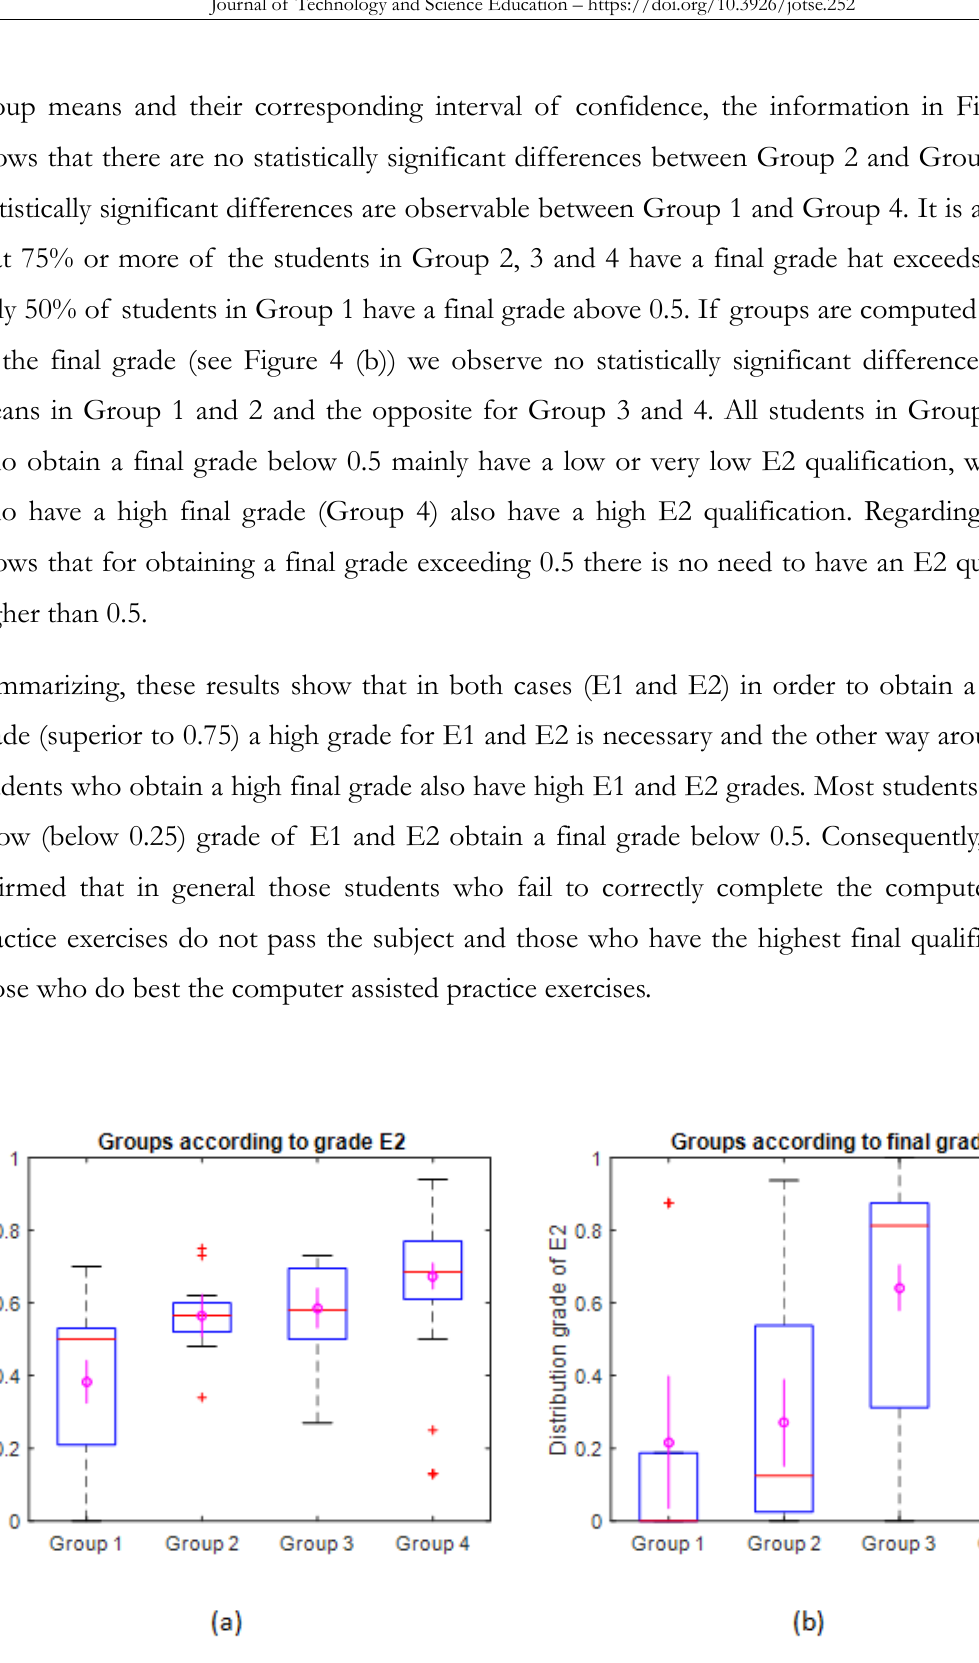
Figure 4. Comparison between E2 and final grade by grouping